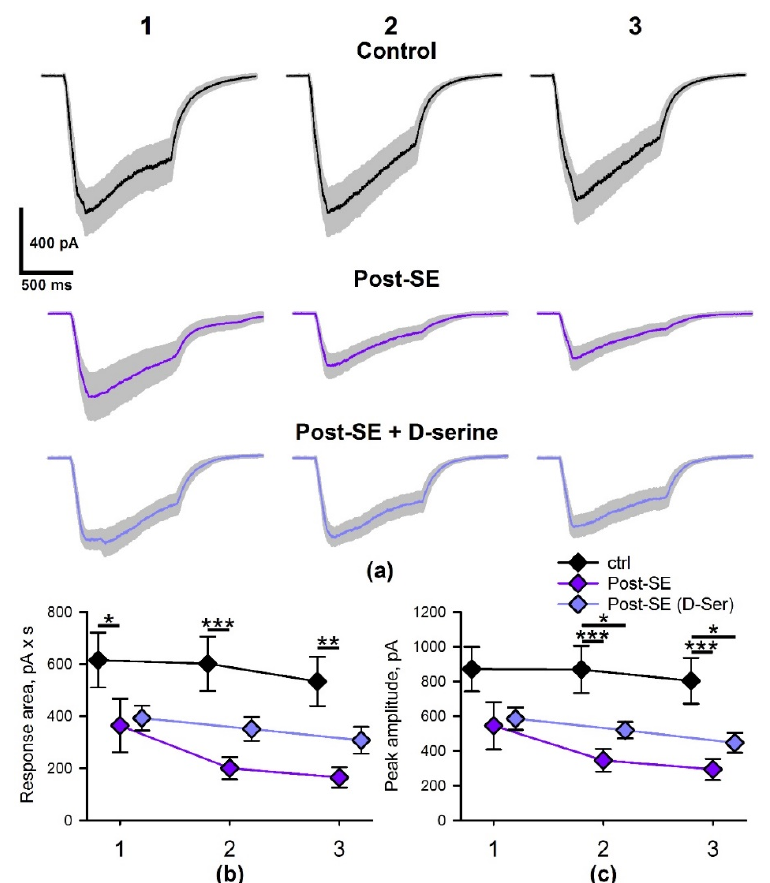
Figure 8. The magnitude of NMDAR-mediated currents evoked by HFS is reduced in post-SE rats. ( a ) The average voltage-clamp recordings of NMDAR-mediated currents, induced by HFS in CA1 neurons in the control (upper trace, n = 10) and post-SE rats without (middle trace, n = 11) and with (lower trace, n = 11) D-serine. Gray areas represent the standard error of the mean. According to the mixed-design ANOVA, the average areas ( b ) and peak amplitude ( c ) of NMDAR-mediated currents in the three groups are significantly different. Asterisks indicate the significant difference between the values, corresponding to the same stimulus train number (Tukey’s test): * p < 0.05; ** p < 0.01; *** p <